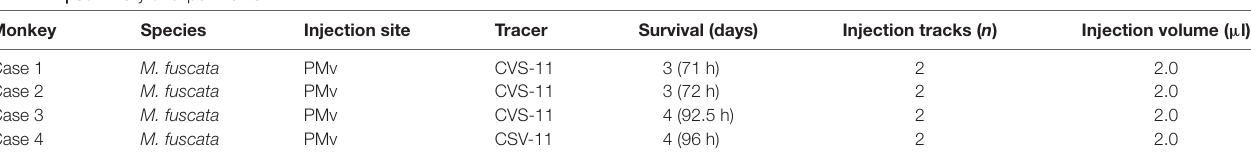
TABLE 1 | Summary of